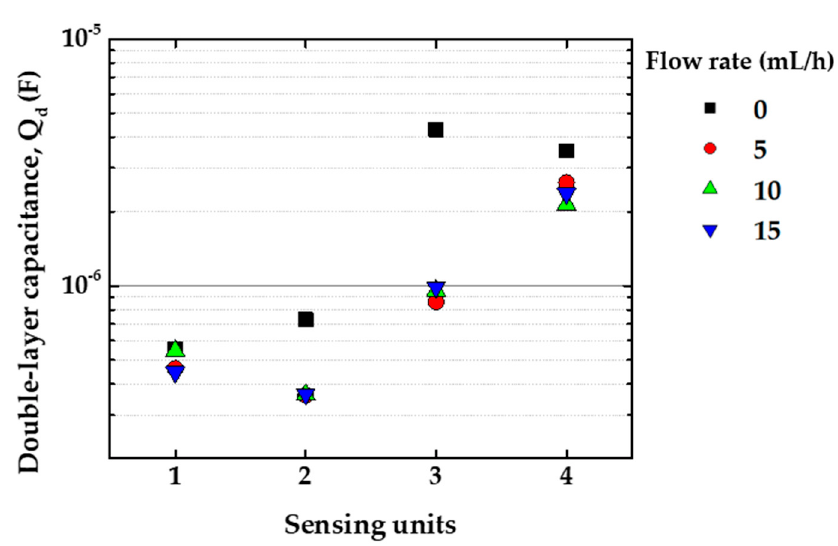
Figure 14. Double-layer capacitance, Q d , obtained by circuit equivalent fitting of each sensing unit for Zero-Cal ® in aqueous solution (10 µ L / mL) from 0 to 15 mL / h flow rates. In the graph, the numbers 1, 2, 3, and 4 on the x -axis are related to the four sensing units: bare IDE, PDDA / CuTsPc, PDDA / MMt-K, and PDDA / PEDOT:PSS, respectively.